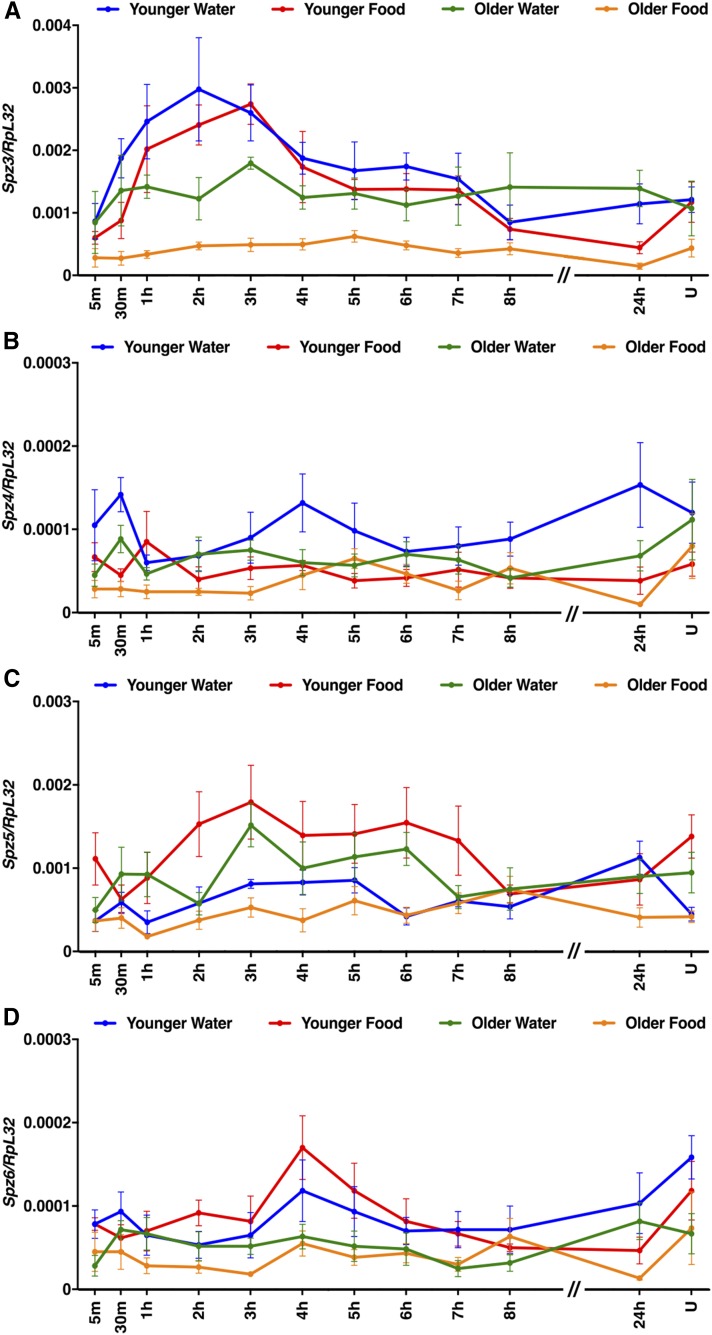
Age and diet affected expression of some Spz family genes following primary injuries. (A–D) Expression of the indicated genes relative to RpL32 following the standard injury protocol in w1118 flies under the indicated conditions. Note that y-axis scales are different among graphs and that the x-axis is not to scale between 8 and 24 hr. U indicates uninjured flies at the 24 hr time point. Each data point is the average and SEM of at least three biological replicates.